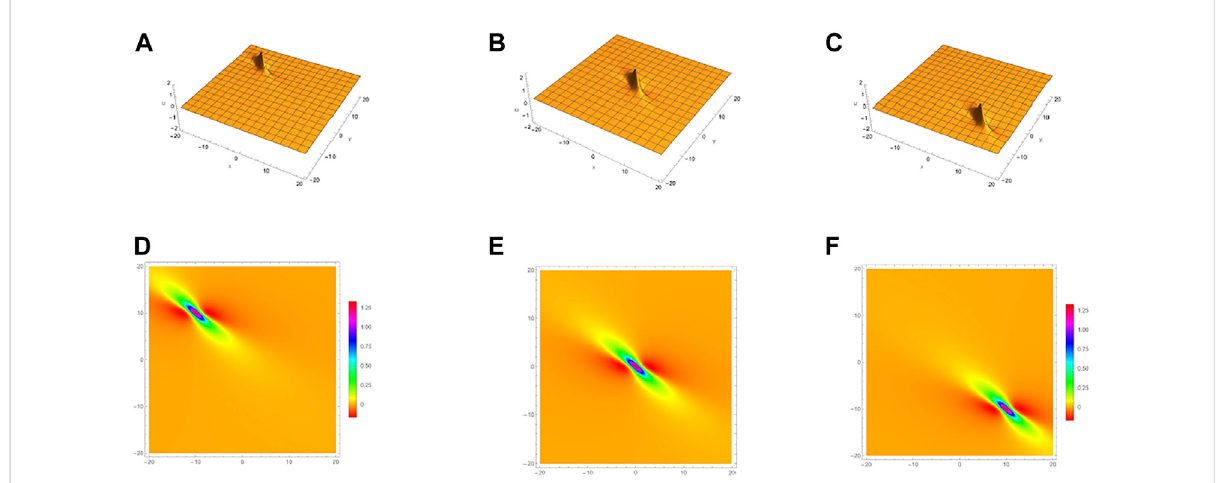
FIGURE 1 1-lump solution Eq. 12 for Eq. 2 with a = 1, b = 1: (A) t = − 1; (B) t = 0; (C) t = 1; (D) , (E) , (F) are the density plot of (A) , (B) , (C) respectively.